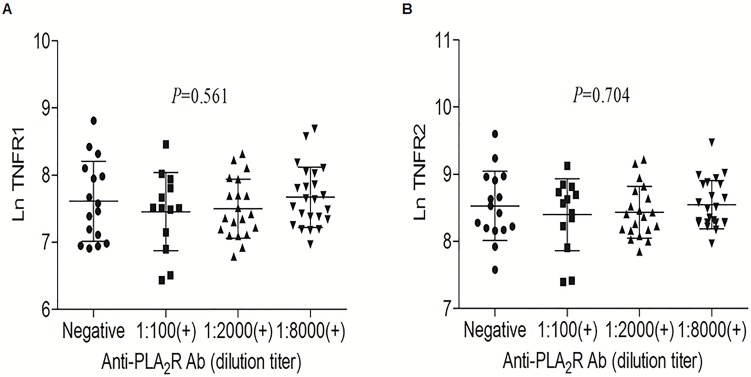
Correlation between the circulating TNFRs levels and autoantibody against phospholipase A2 receptor (anti-PLA2R).(A) The statistically insignificant relationship between Ln cTNFR1 level and anti-PLA2R. (B) The statistically insignificant relationship between Ln cTNFR2 level and anti-PLA2R.